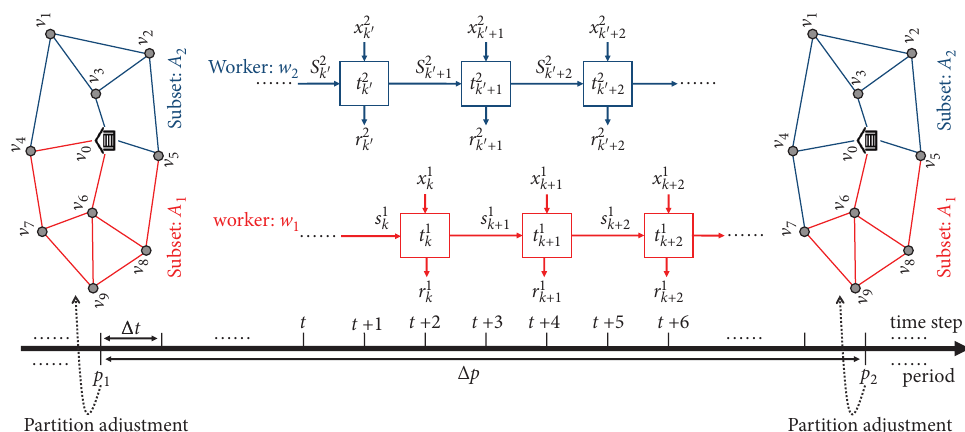
Figure 4: An illustration of the decomposition of decision